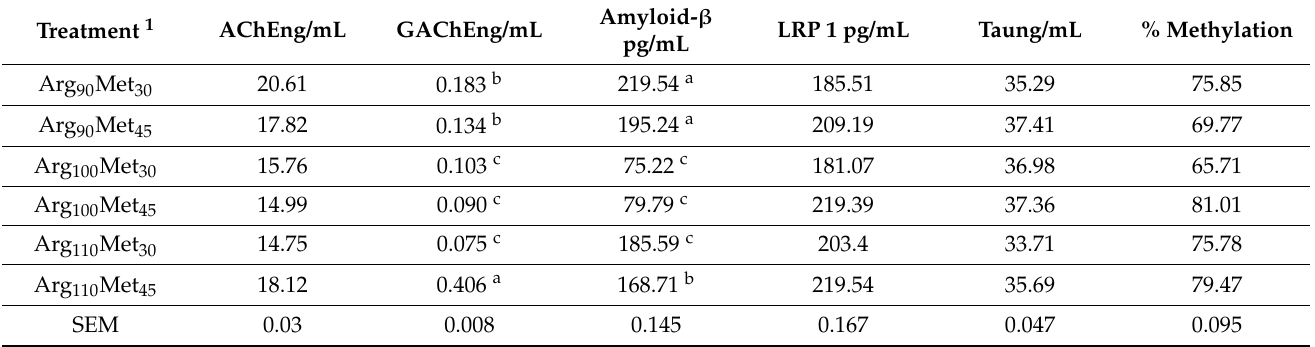
Table 7. Indicators of neurodegenerative changes in the liver of turkeys, Experiment